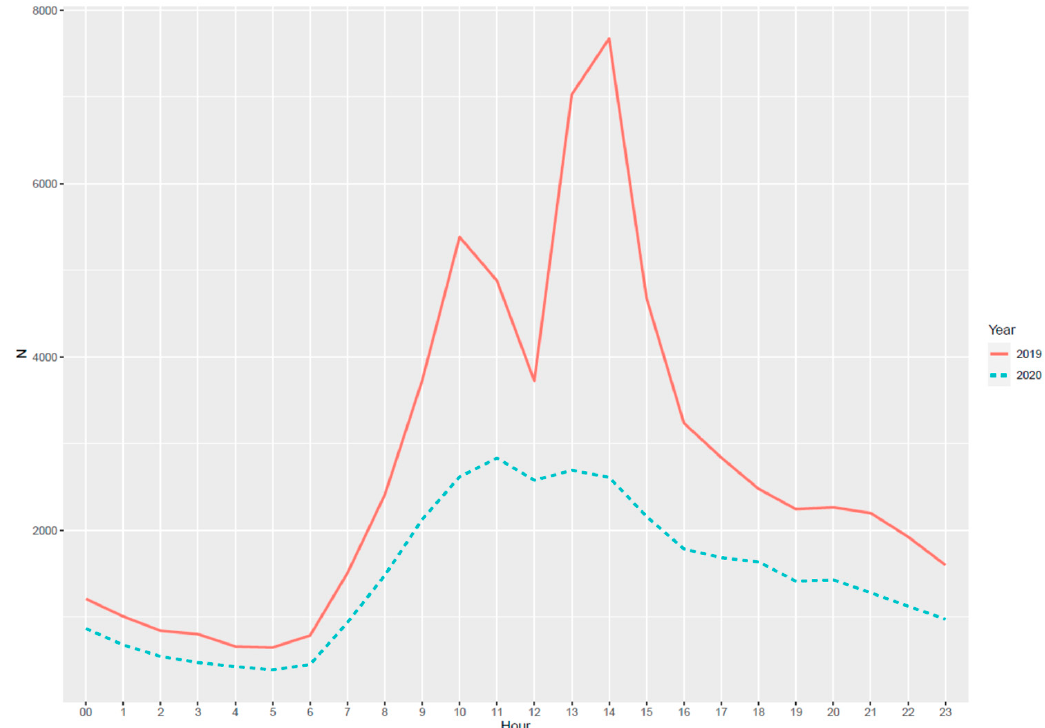
Figure 2. Hourly referrals to ED in 2019 and 2020. The bimodal distribution denotes a drop in the presentations due to shift change in the ED tracks dedicated to dermatologic-, ophthalmologic-, and ear-nose-throat-related conditions.